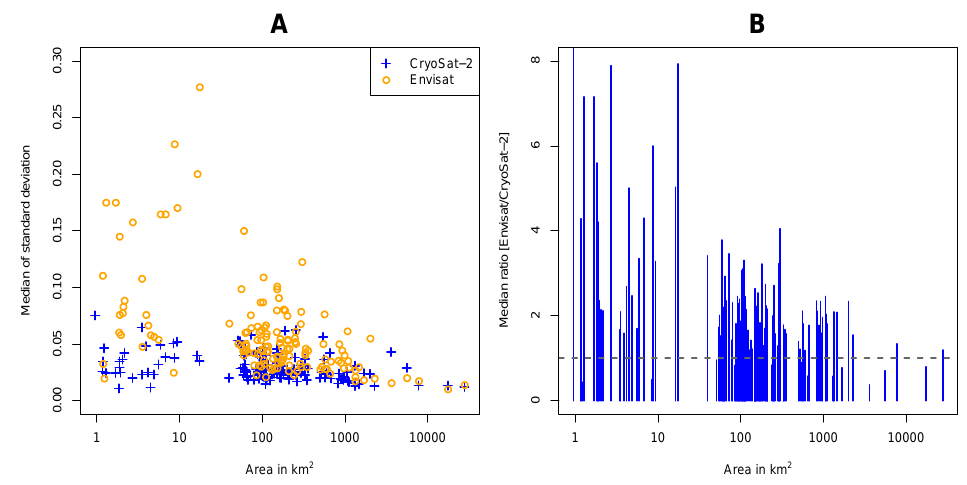
Figure 4. ( A ) the MSD of CryoSat-2 (blue) and Envisat (orange) as a function of Area; ( B ) the MSD ratio as a function of area. Values above and below 1 indicate ratios, where CryoSat-2 or Envisat have the lowest MSD, respectively.